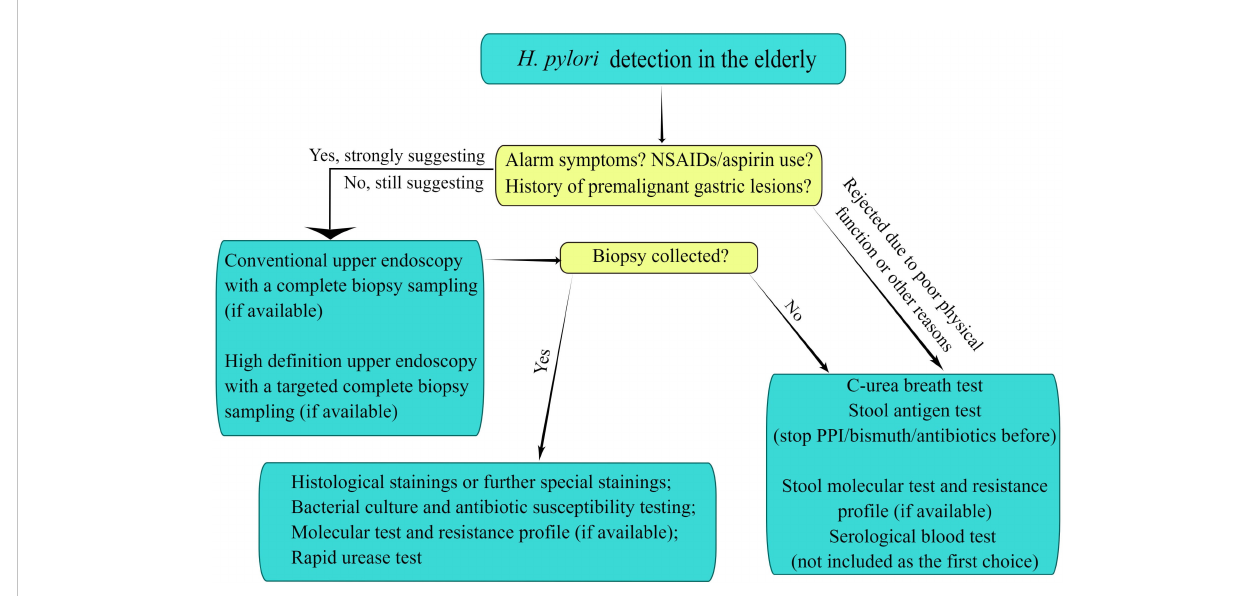
FIGURE 1 Diagnostic evaluation to detect Helicobacter pylori infection in the elderly. The fi gure is drawn by